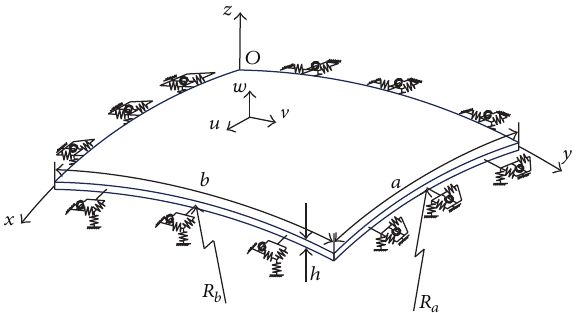
Figure 2: Geometrical parameters and coordinate system of a doubly curved shallow shell with elastically restrained